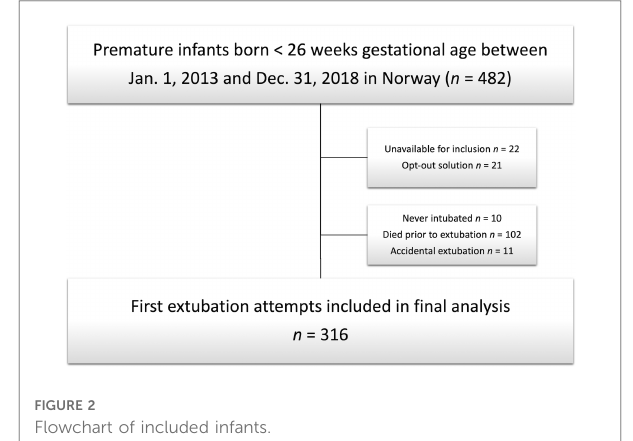
FIGURE 2 Flowchart of included